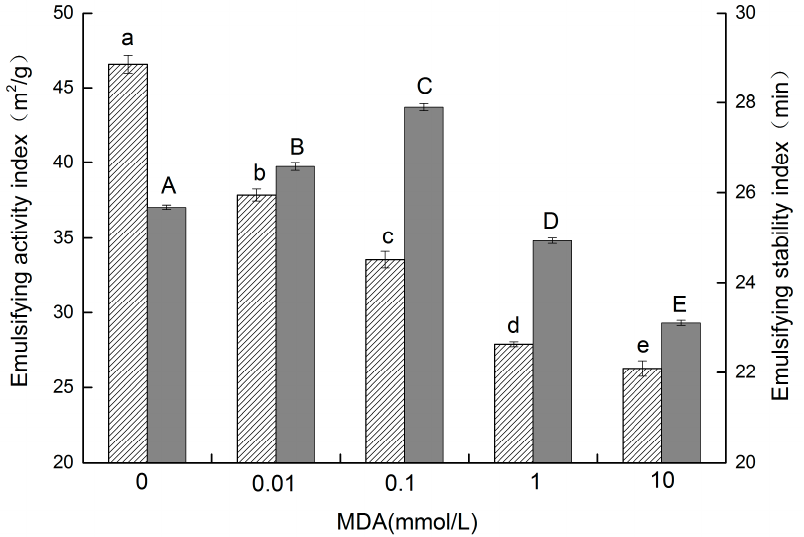
Figure 5. EAI and ESI of walnut protein at different concentrations of MDA (The EAI is represented by the column with oblique lines , and the ESI is represented by the gray column . The different letters in the same indicator indicate significant difference at p < 0.05).